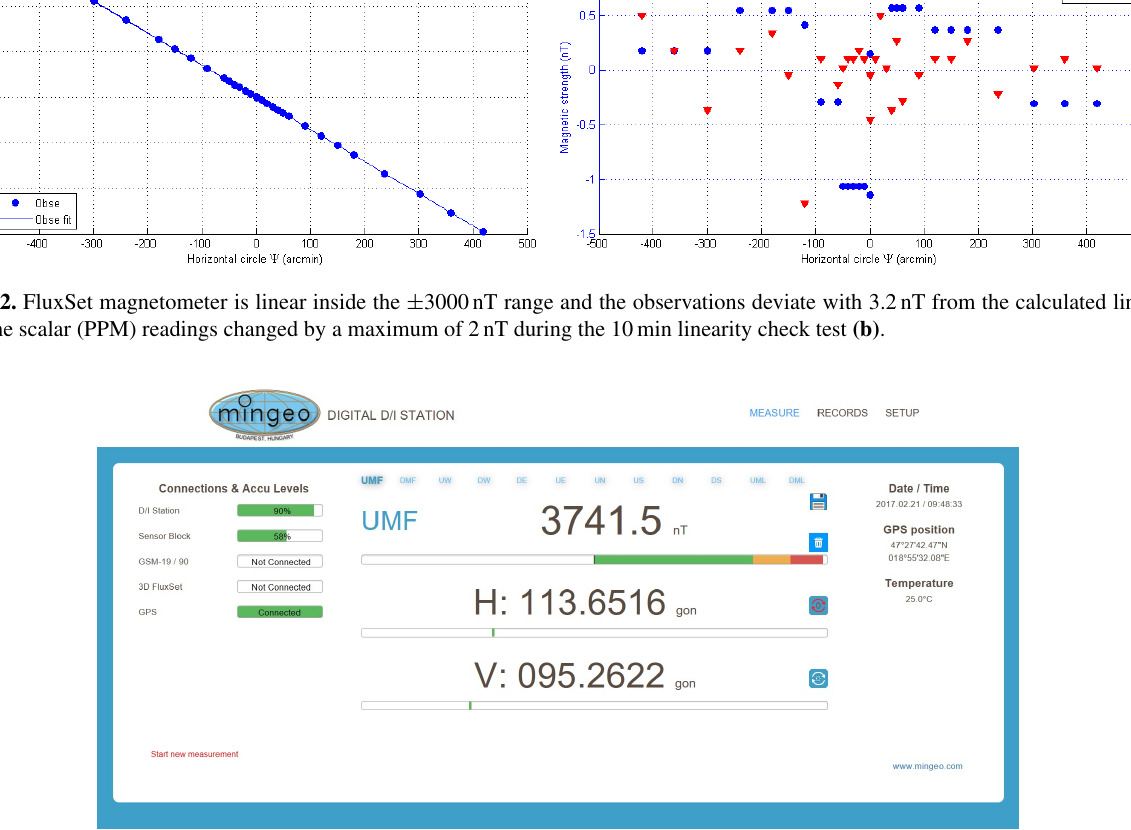
Figure 3. The measurement tab of the GUI web page. On the left side is connection and battery life information. On the right side is date, time, GPS and temperature data. In the middle of the tab the current magnetic sensor reading is shown with its corresponding horizontal and vertical angle values. In the top and middle panels the predefined measurement sequence can be seen, which begins with the first azimuth reading with the telescope in an upward position (UMF) and emphasis on the ongoing